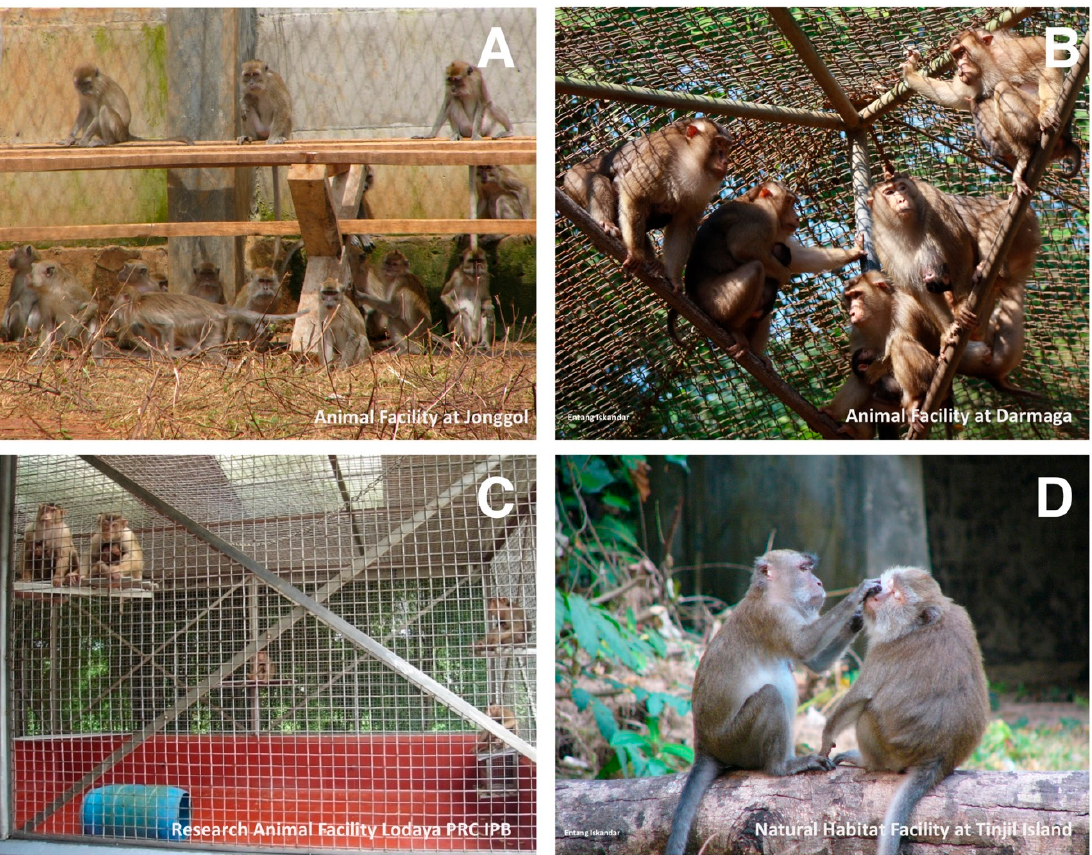
Figure 2. Cynomolgus macaques ( Macaca fascicularis, A and D ) and pig-tailed macaques ( Macaca nemestrina, B and C ). Jonggol, Darmaga, and Lodaya facilities ( A–C ) are captive enclosures, whereas Tinjil Island is a natural habitat facility ( D ). Photos courtesy of Entang Iskandar and RAFL PRC